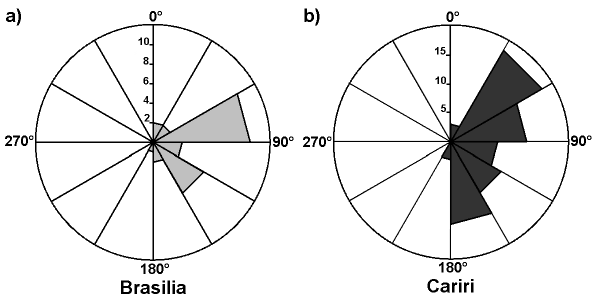
Fig. 4. Plots summarizing the number of wave events versus the direction of propagation (summed into 30 ◦ bins) for Brasilia (left) and Cariri (right). Note the different